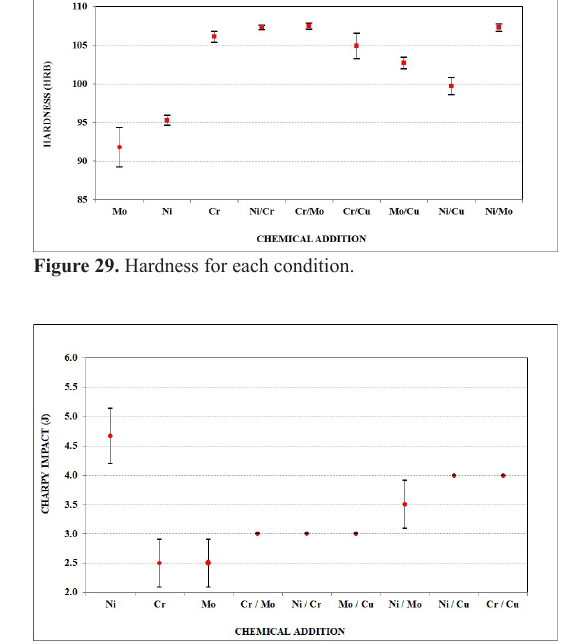
Figure 33. Fractured surface of Cr/Mo.